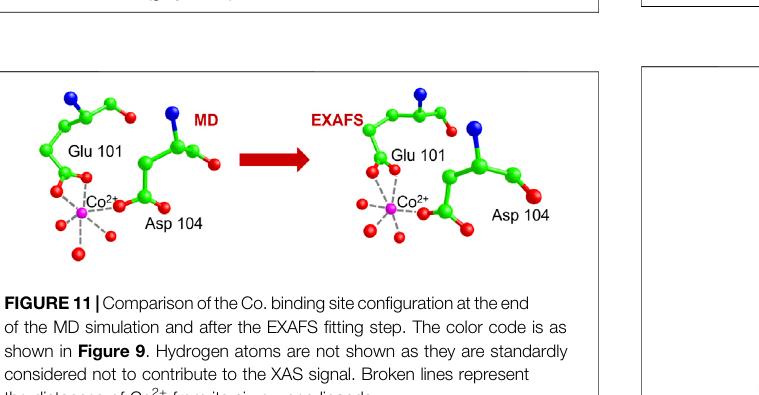
FIGURE 10 | Experimental EXAFS spectrum of wt_90_0.8 (red curve) and best- fi t model (grey curve).